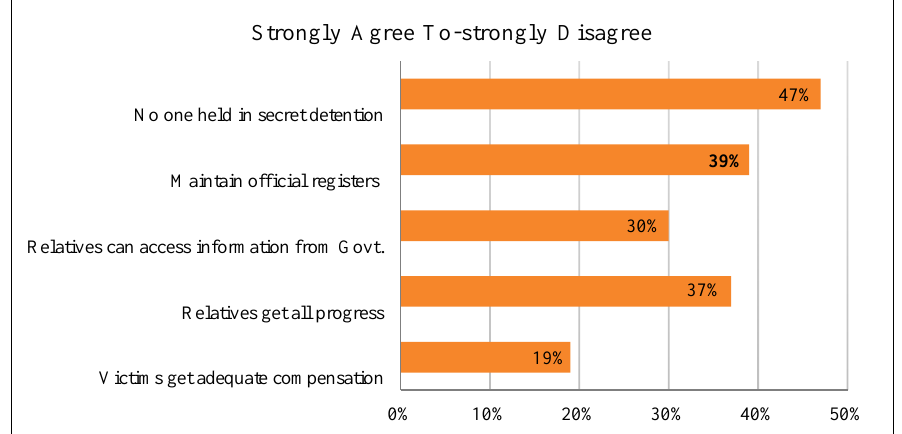
Figure 5. Illustrates a limited level of compliance with the Convention particularly on compensation, investigation